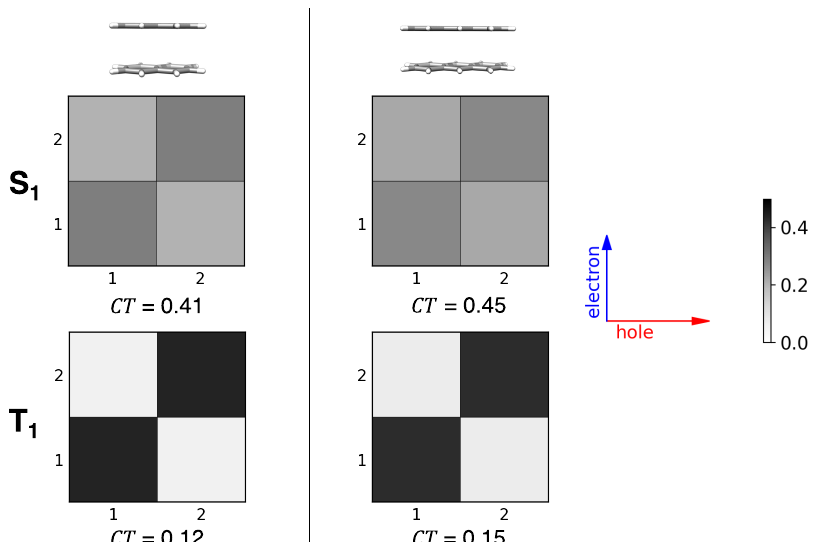
Figure 11. Lowest energy singlet and triplet exciton-state analysis via electron-hole correlation plots [71] for naphthalene and anthracene dimers in their eclipsed configuration. The grey scale used is shown on the right panel. From TDA- ω B97X-D/6-31G* calculations. The magnitude of the CT contribution is shown on the bottom part of each panel.